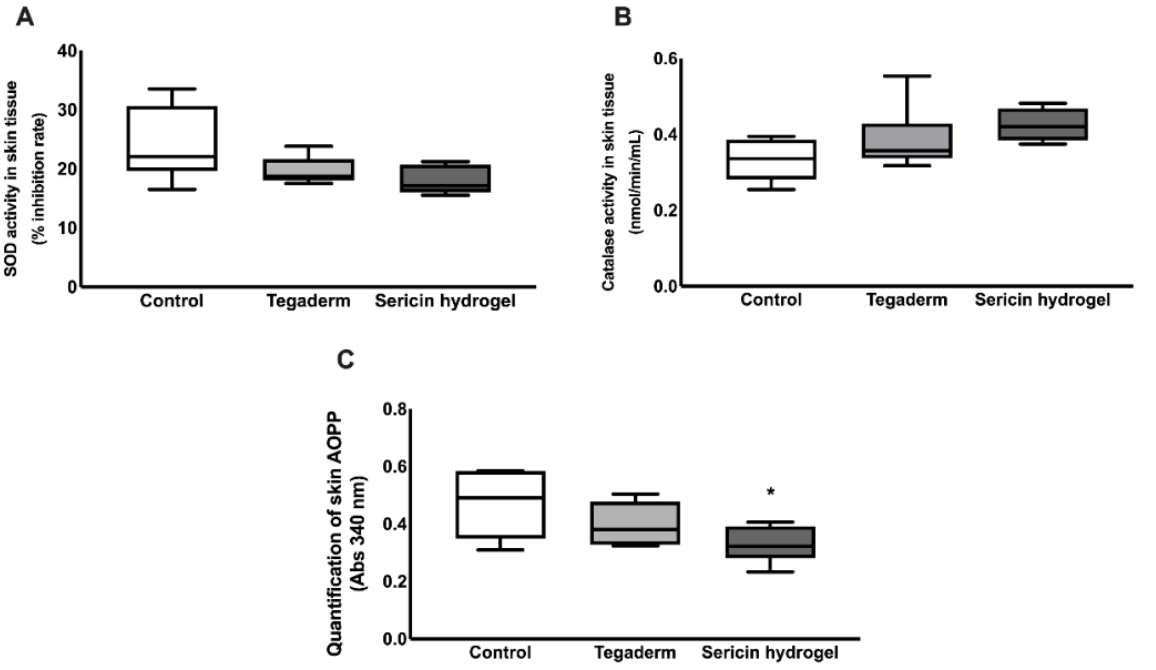
Figure 8. Quantification of antioxidant defenses at the wound bed on diabetic animals that were treated with sericin hydrogel and covered with Tegaderm, wounds only covered with Tegaderm, or wounds that were left untreated (control), in an animal model of a skin wound healing assay. ( A ) Superoxide dismutase (SOD) activity by enzymatic assay (expressed as % of inhibition rate); ( B ) Catalase activity, by enzymatic assay and expressed as nmol/min/mL; ( C ) Quantification of advanced oxidation protein products, assessed by a colorimetric assay. The results are expressed as the mean ± SD (n = 6) (* p value ≤ 0.05 in comparison to control). AOPP, Advanced Oxidant Protein